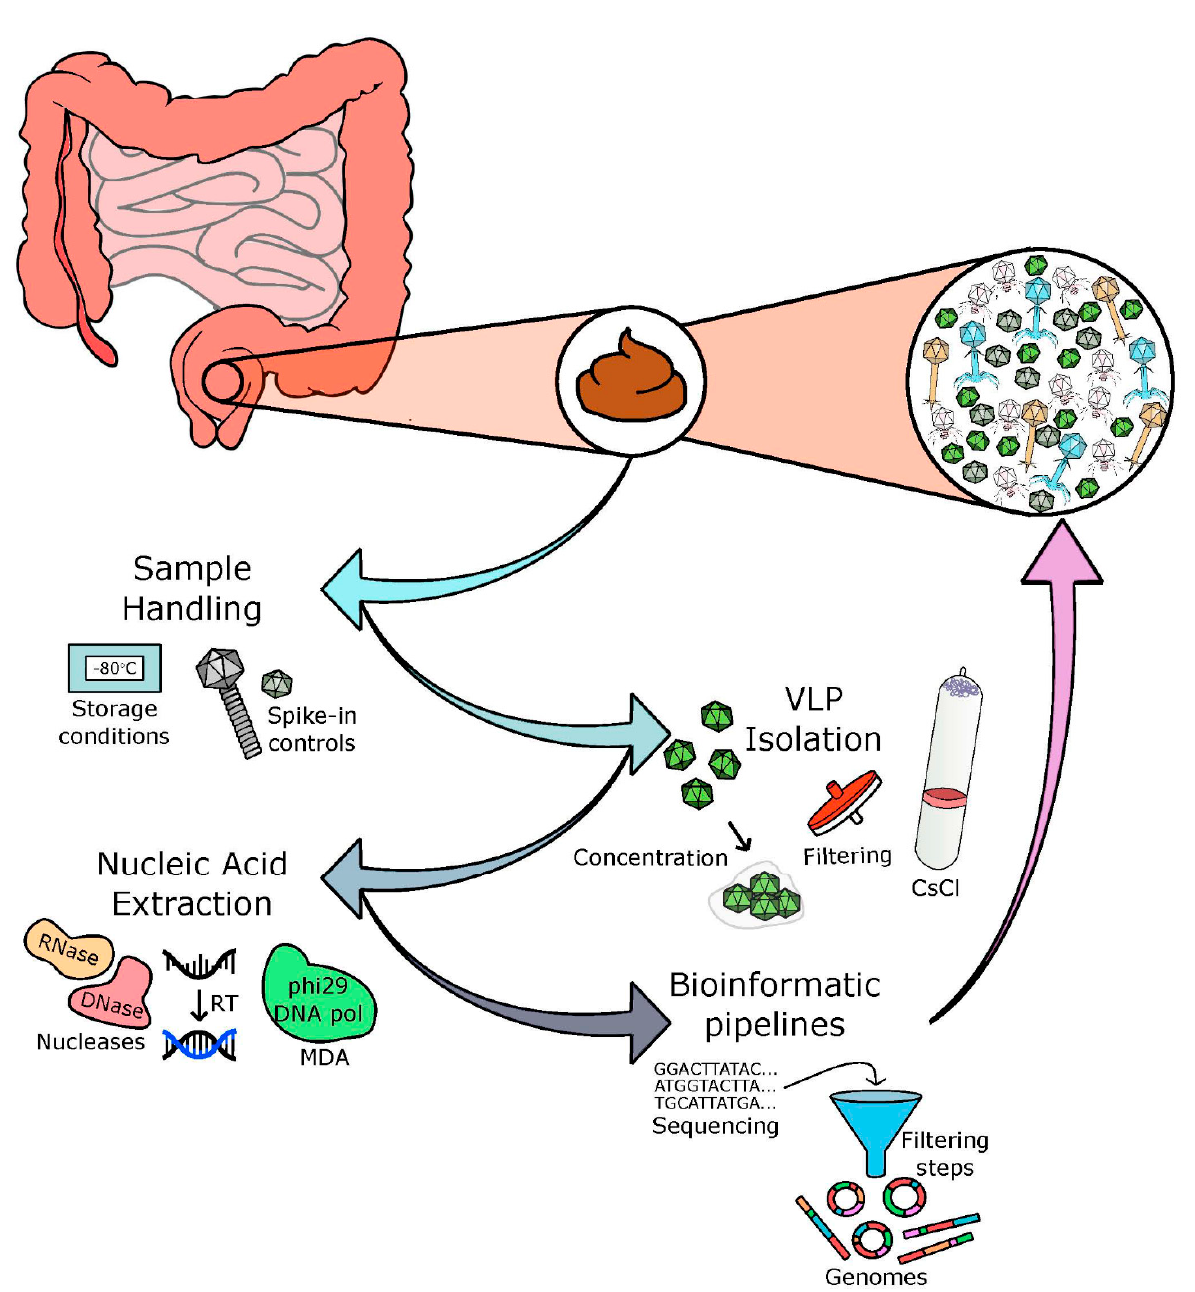
Figure 1. Basis of a viral/phage isolation protocol. Faecal samples are often used as a proxy for the human gut virome. Through four main processes, the viral and phage communities of the human gut are analysed: ( i ) acquisition and storage of samples, ( ii ) concentration of viral particles, ( iii ) extraction of pure nucleic acids with the elimination of free nucleic acids, and ( iv ) successful sequencing and bioinformatic analysis of these nucleic acids.